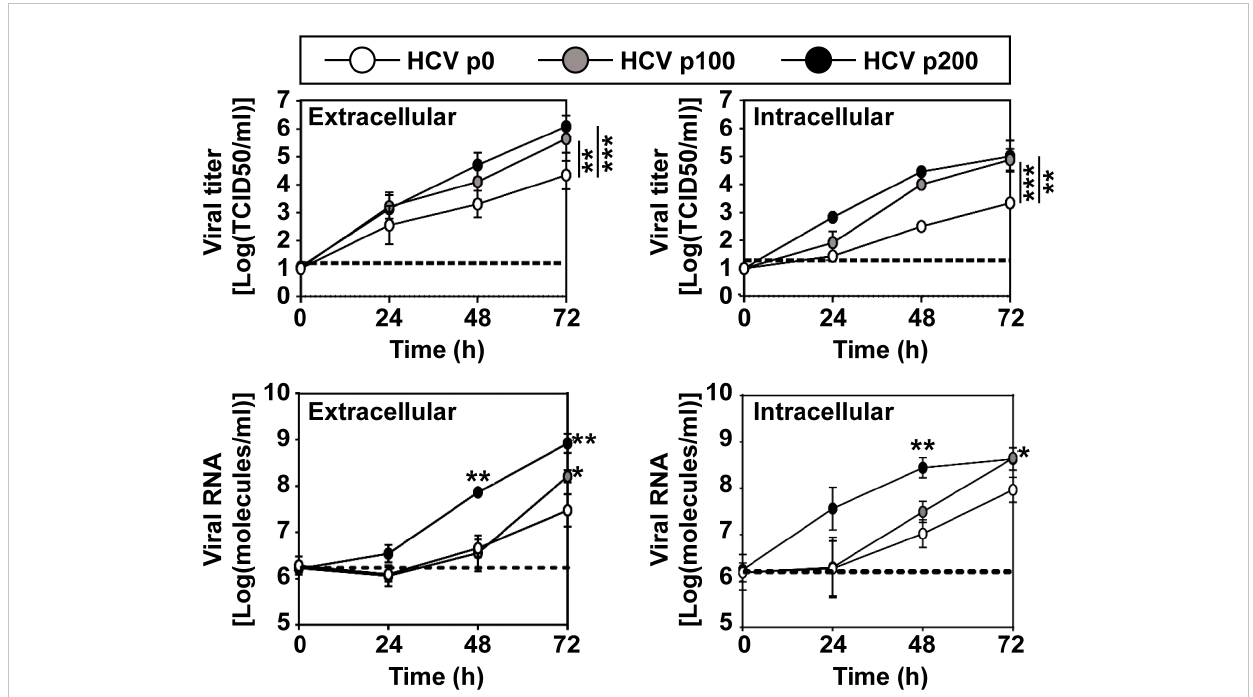
FIGURE 1 Kinetics of viral progeny production by HCV p0, HCV p100 and HCV p200. Huh 7.5 cells were either mock-infected or infected with the indicated virus (top box) at a MOI of 0.03 TCID 50 /cell (4 x 10 3 Huh-7.5 cells infected with 1.2 x 10 4 TCID 50 of virus). Extracellular and intracellular infectivity and viral RNA were quanti fi ed. Results are the average of three independent experiments (biological triplicate). Data were transformed to the logarithmic values as indicated in ordinate. The statistical signi fi cance of the differences was calculated using the ANCOVA test (*p < 0.05; **p < 0.01; ***p < 0.001). Data on viral titers (upper two panels), have been previously published in (Moreno et al., 2017), and are included here to complement information on HCV fi